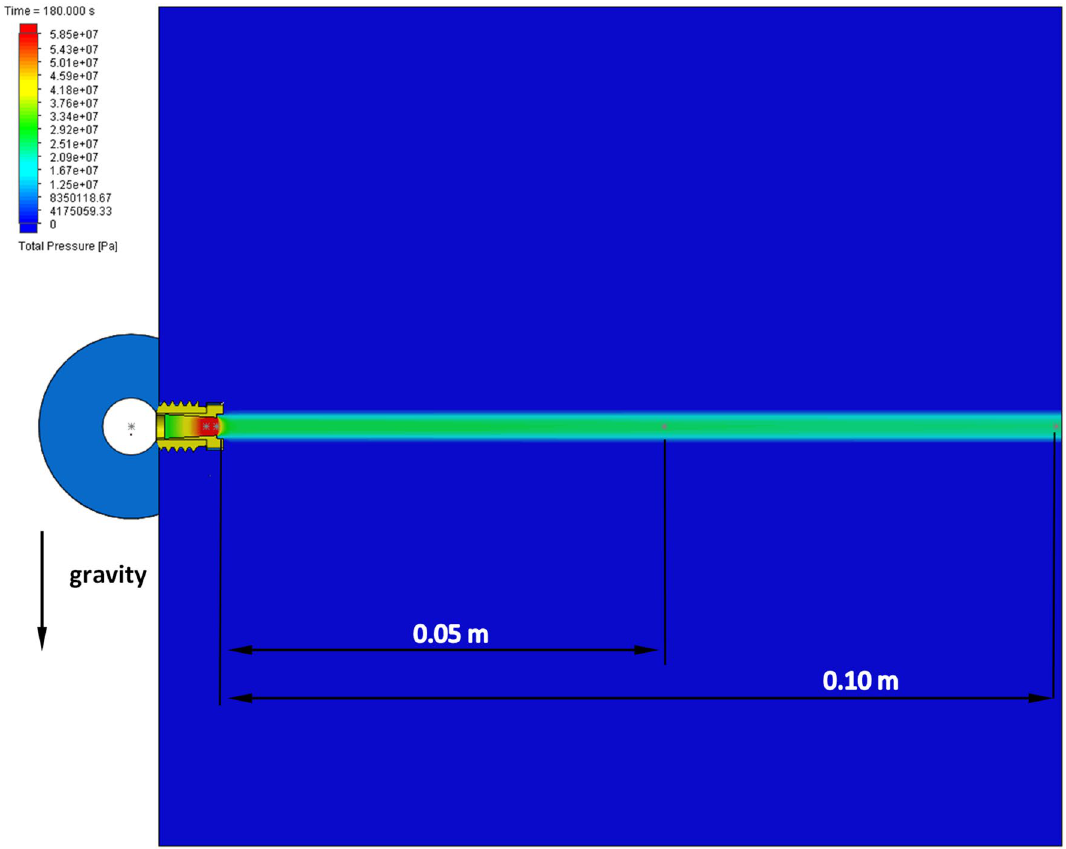
Figure 13. A map of water pressure changes: ( a ) cross-section, ( b )